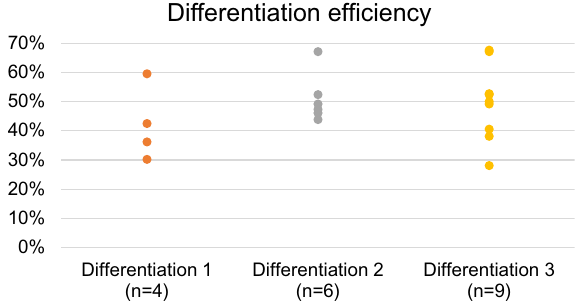
Figure 1. Human iPSC-CMs differentiation efficiency for three independent differentiations of m34Sk3 cell line. Quantification was done on the basis of optical mapping fluorescence data (Ca 2+ ) of obtained cardiac